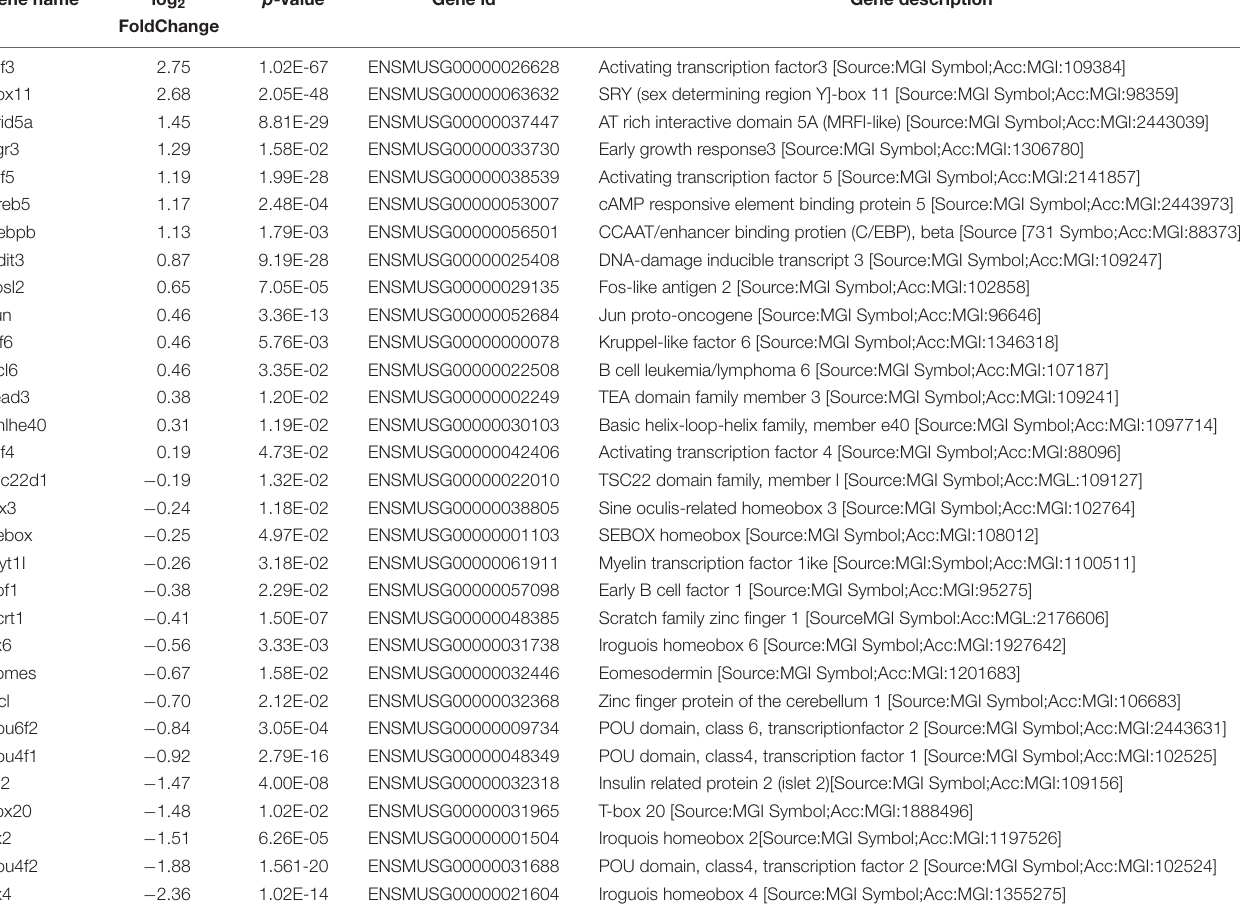
TABLE 2 | Transcription factors regulated by ONC